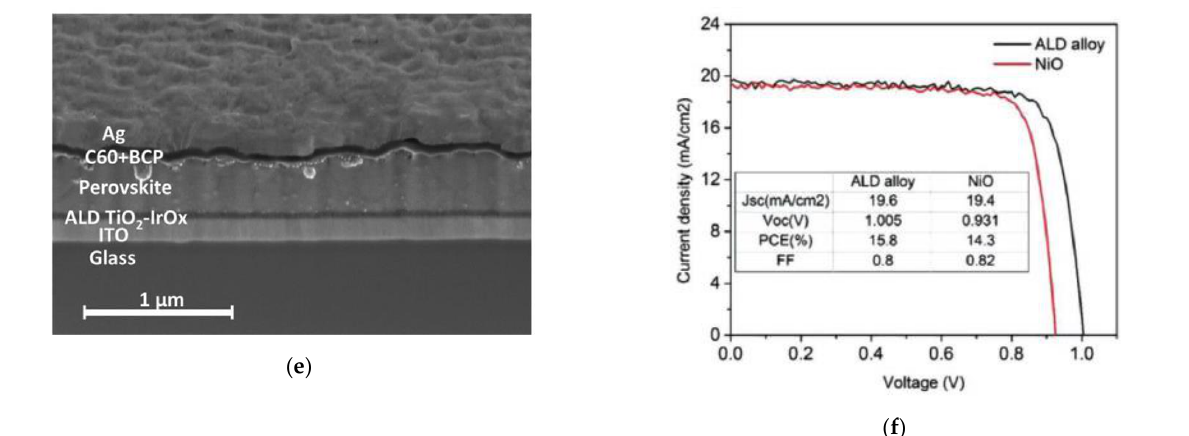
Figure 3. Incorporation of ALD processes for NiO, TiO 2 , and aluminum-doped zinc oxide (AZO) in PSC: ( a ) Schematic of solar cell device stack and cross-sectional scanning electron microscopy image of the PSC device; ( b ) Illuminated J–V scans comparing PSCs with ALD TiO 2 and ALD AZO. Reproduced from [47], with permission from Wiley, 2018. Incorporation of atmospheric pressure spatial ALD (s-ALD) processes for NiO x as hole transport layer (HTL) in PSC: ( c ) Cross-sectional SEM image of the PSC device; ( d ) Illuminated J–V scans comparing PSCs with the conventional HTL, poly(3,4-ethylenedioxythiophene) polystyrenesulfonate (PEDOT:PSS), and s-ALD NiO x (right). Reproduced from [45], with permission from the American Chemical Society, 2018. Incorporation of ALD processes for TiO 2 -IrO x as HTL in PSC: ( e ) Cross-sectional scanning electron microscopy image of PSC device; ( f ) Illuminated current density vs. voltage comparing PSCs with ALD TiO 2 -IrO x and nanoparticle NiO. Reproduced from [43], with permission from Wiley,